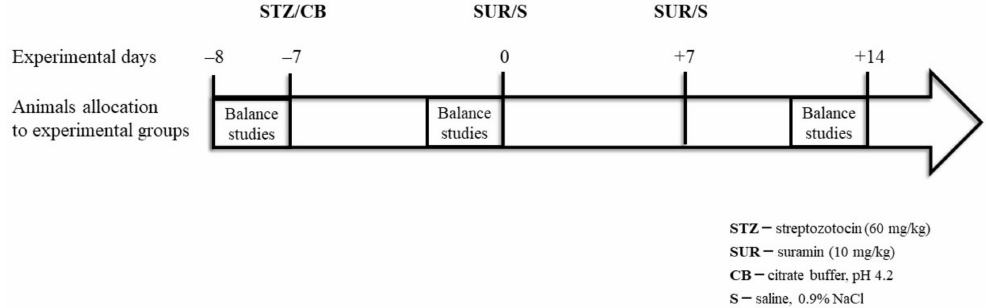
Figure 9. Schema of the experimental